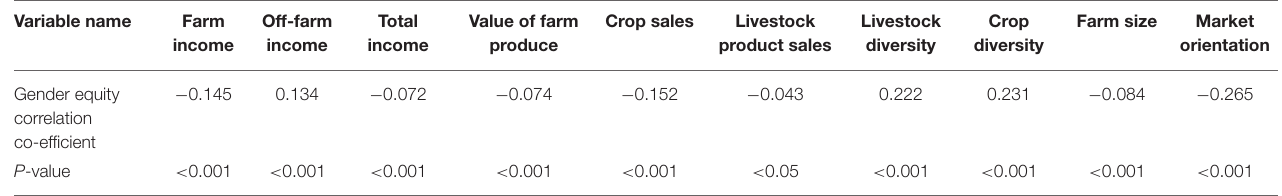
TABLE 5 | Correlation table between female control indicator and income, crop, livestock, and market orientation indicators across all systems ( n = 2,859).